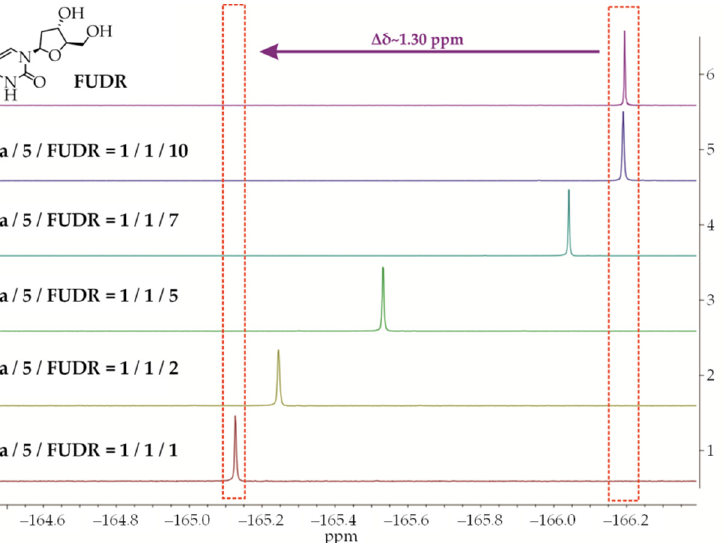
Figure 8. 19 F-NMR spectra with proton decoupling (1 × 10 − 3 M) in D 2 O at 298 K: 1) 3a / 5/ FUDR in the ratio 1:1:1; 2) 3a / 5/ FUDR in the ratio 1:1:2; 3) 3a / 5/ FUDR in the ratio 1:1:5; 4) 3a / 5/ FUDR in the ratio 1:1:7; 5) 3a / 5/ FUDR in the ratio 1:1:10; 6) FUDR.